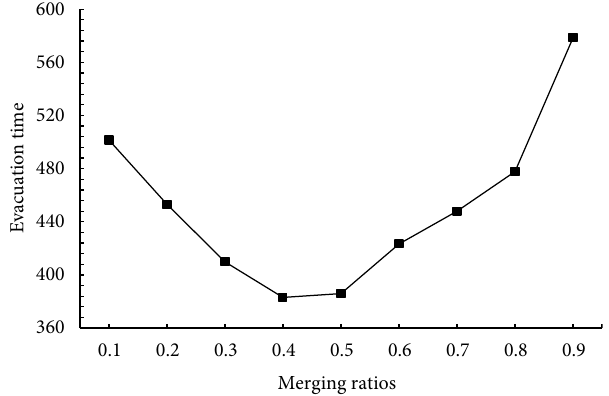
Figure 5: Evacuation time of stairs for the different merging